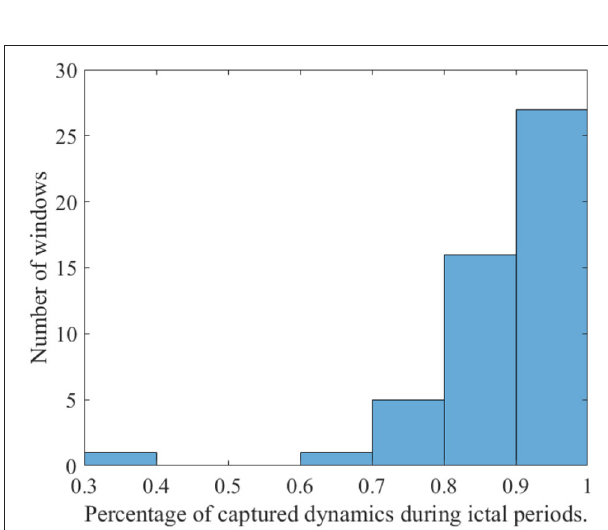
FIGURE 3 | Histogram of the signal representation during ictal